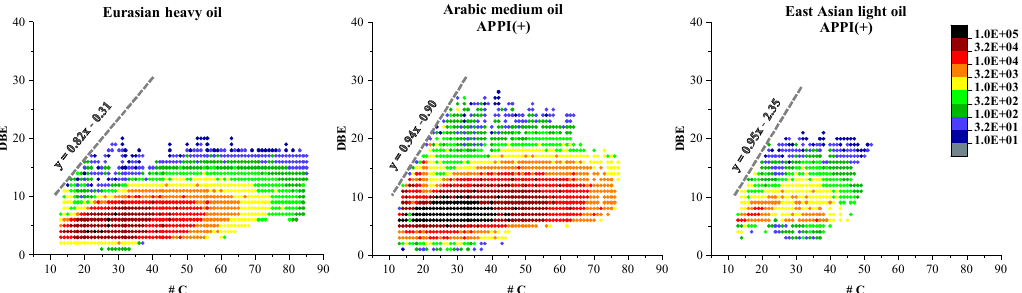
Figure 7. Kendrick plots of the S class for APPI( + ) measurements of saturates from Eurasian heavy oil ( left ) Arabic medium oil ( middle ) and E. Asian light oil ( right ). Color-coding represents the intensity of the corresponding monoisotopic signal.